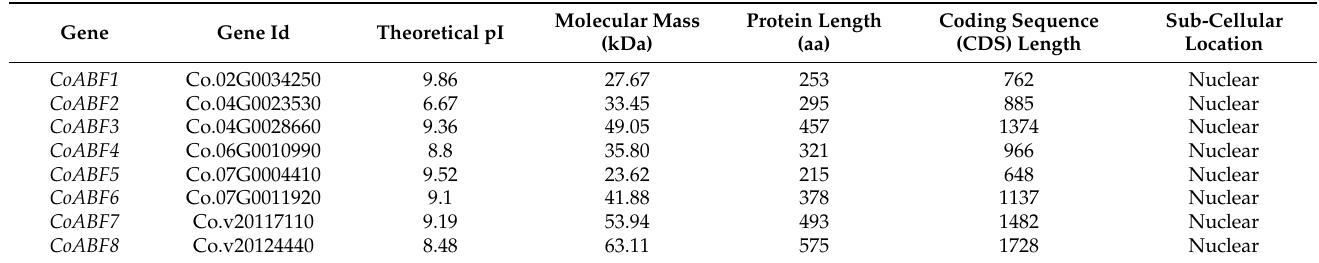
Table 1. Characteristics of AREB/ABF subfamily members in C. olitorius genome.